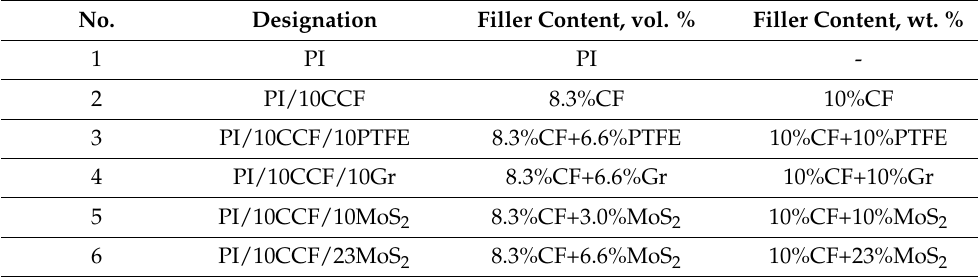
Table 1. The compositions of the studied PI-based